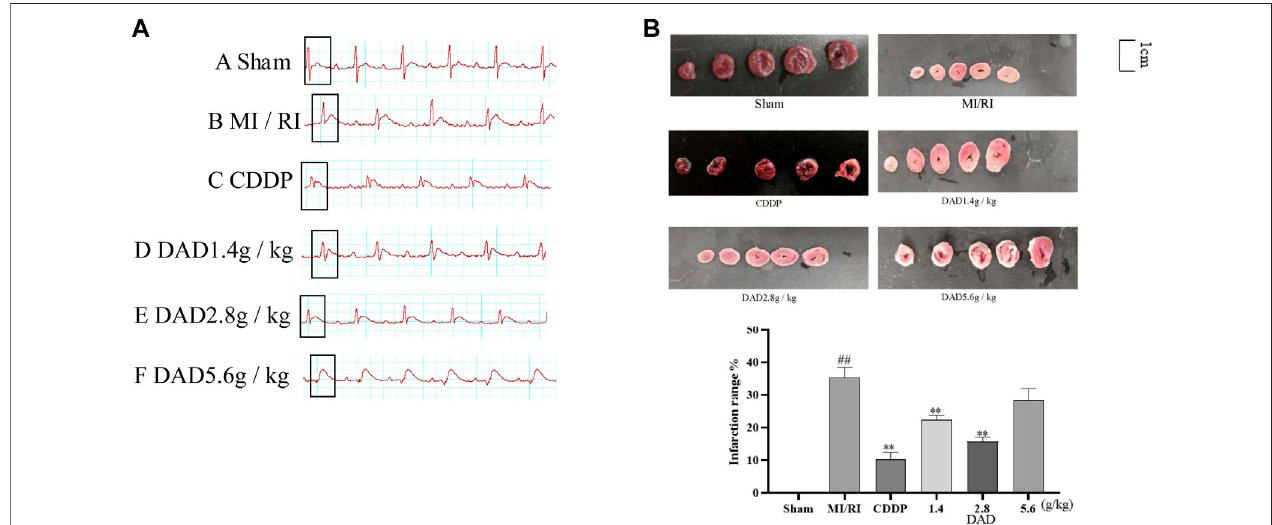
FIGURE 5 | Changes of electrocardiogram in MI/RI rats and effects dried ginger-aconite decoction (DAD) on myocardial infarction area in MI/RI rats. (A) After modeling,ECGchangesinShamgroup,MI/RIgroup,CDDPgroupandDAD(1.4 g/kg,2.8 g/kg,5.6 g/kg)groups. (B) EffectsoninfarctionrangereductionofI/Rinjured rats. Data were presented as mean standard deviation (SD). # p < 0.05, ## p < 0.01 vs. sham group. * p < 0.05, ** p < 0.01 vs. MI/RI group.